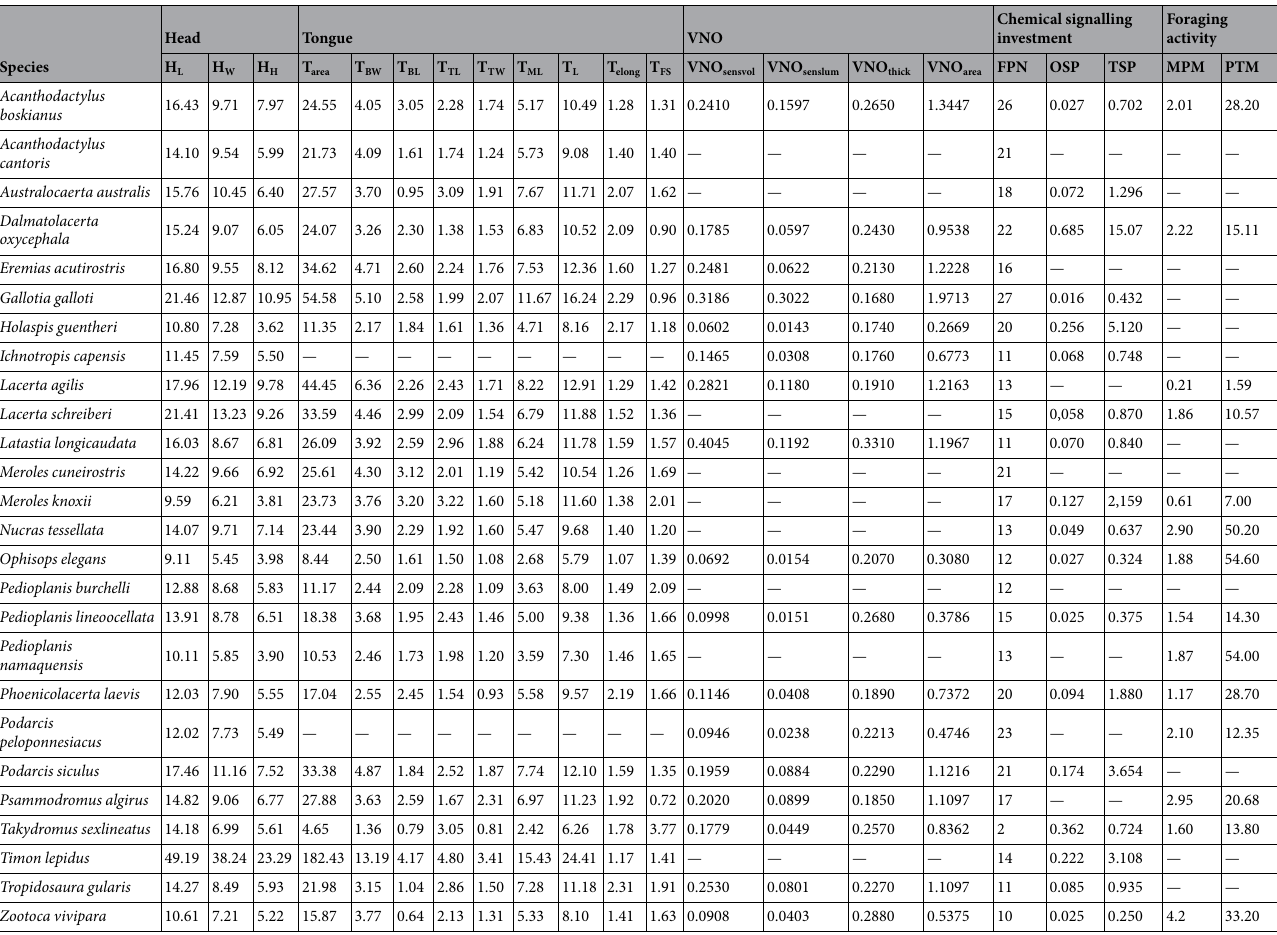
Table 1. Morphometrics of the tongue and vomeronasal organs of lacertid lizards, with additional data on proxies for chemical signalling investment and foraging behaviour activity. Abbreviations: H L = head length, H W = head width, H H = head height, T area = tongue surface area, T BW = tongue base width, T BL = tongue base length, T TL = tongue tip length, T TW = tongue tip width, T ML = tongue mid length, T L = total tongue length, T elong = tongue elongation, T FS = tongue-fork score, VNO sensvol = volume of VNO sensory epithelium, VNO senslum = volume of VNO lumen, VNO thick = thickness of VNO sensory epithelium, VNO area = surface area of VNO sensory epithelium. All length measurements are noted in mm, area in mm 2 , and volumes in mm 3 . Average number of femoral pores (FPN), one-gland secretion production (OSP), total secretion production (TSP), foraging variables PTM (percentage time moving) and MPM (number of movements per